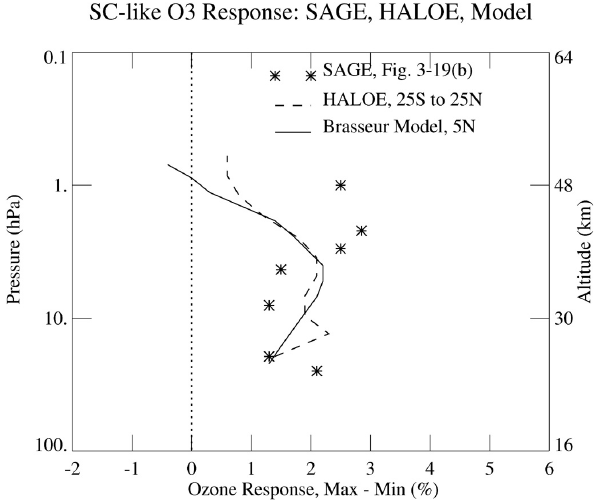
Fig. 1. Solar cycle (or SC-like) ozone response profiles for 25 ◦ S to 25 ◦ N from HALOE, from the published analyses of 1979-2005 SAGE data (WMO, 2007, their Fig. 3.19b), and at 5 ◦ N from the model of Brasseur